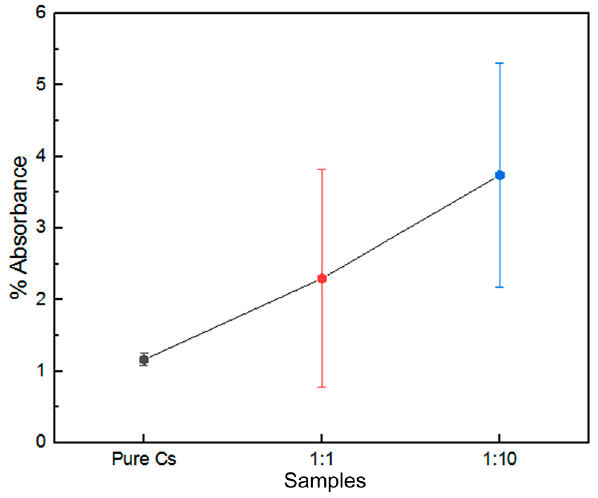
Figure 6. Absorbance of the C–H stretching bands present in pure chitosan (Cs), 1:10 polyaniline– chitosan (PAni–Cs), and 1:1 PAni–Cs composites.